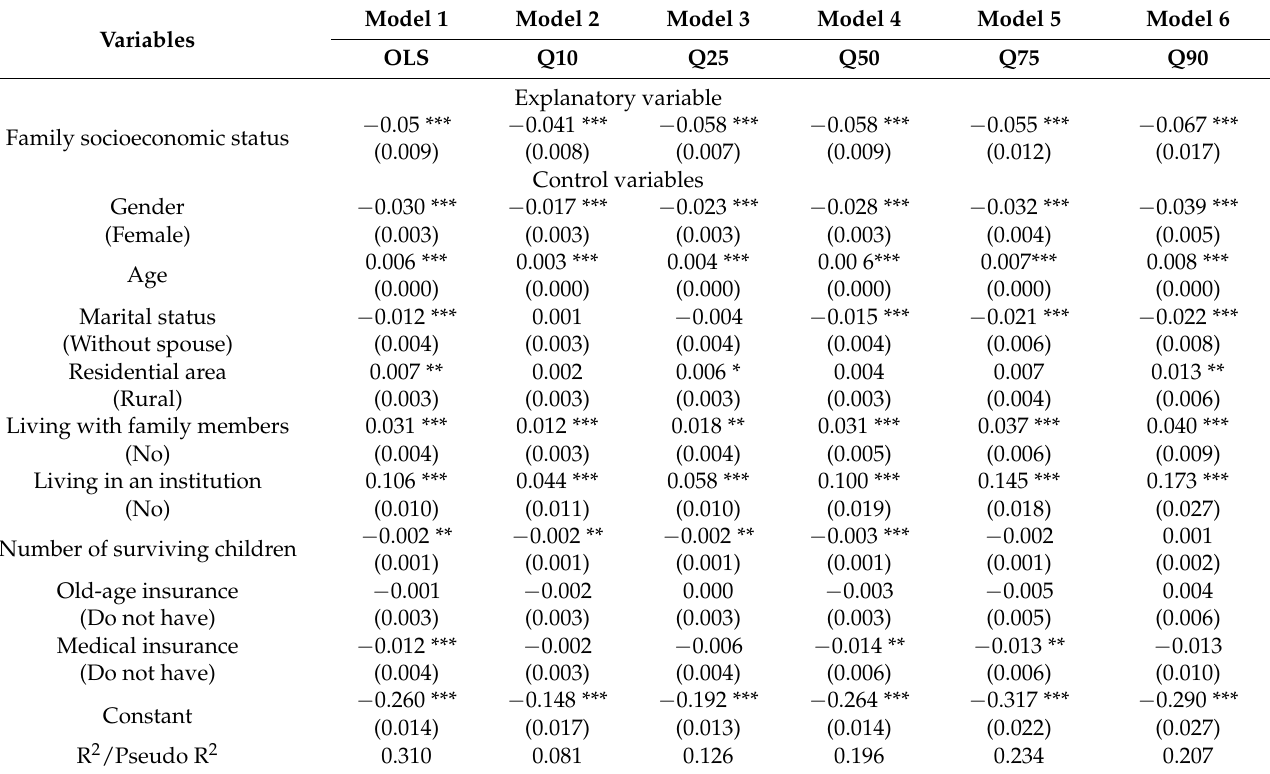
Table 2. Regression results of the impact of family socioeconomic status on elderly